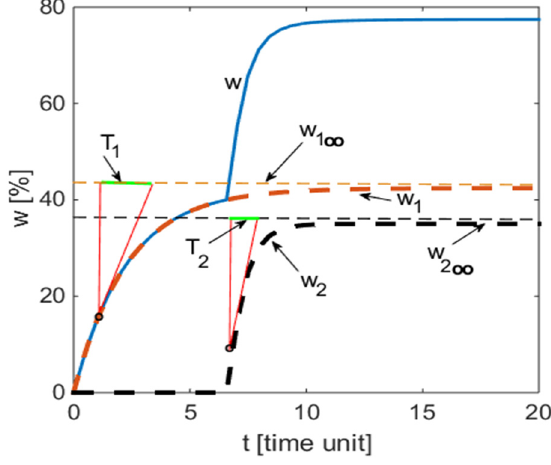
Figure 2. The time profile of weight loss depicted by Equation (6) and its components. From a systemic point of view, models (2)–(6) hide the fact that the biodegradation process corresponds to a dynamic system with distributed parameters. The idea of a “system with distributed parameters” is not addressed in this paper. We only limit to the issue of the behavior of a “dynamic system”. In this context, the starting point consists of two